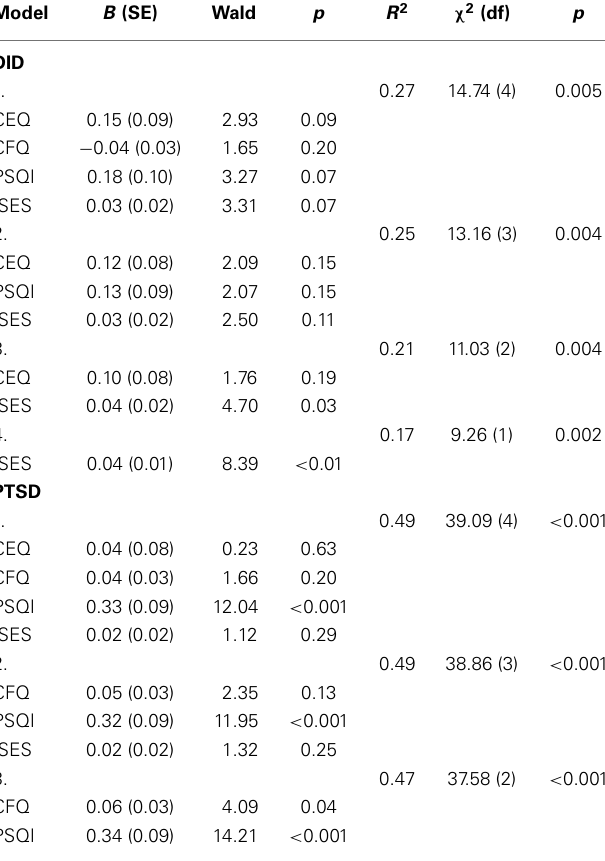
Table 3 | Summary of backwards binary logistic regression analyses on DID group ( N = 12), PTSD group ( N = 27), and combined psychopathology group ( N = 39)